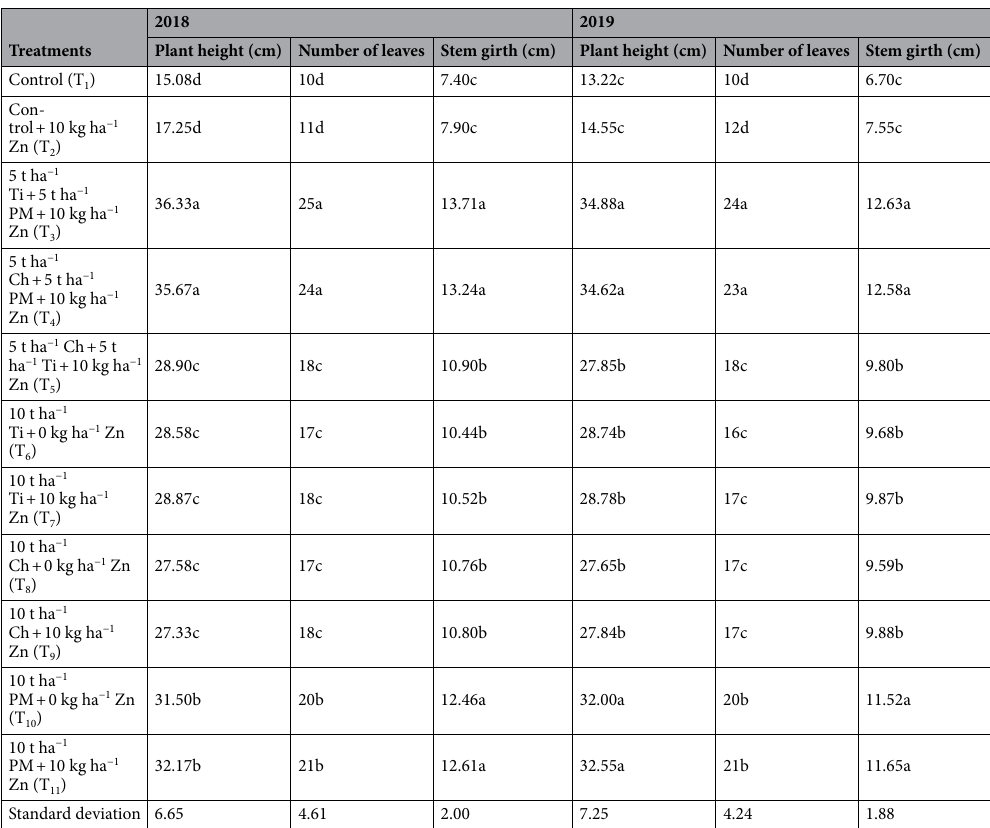
Table 3. Effects of soil applied Zn-fertilizer, green biomass and poultry manure on vegetative parameters of okra at 7 weeks after sowing (WAS) in 2018 and 2019 cropping seasons. Means in a column under any given treatment followed by the same letter do not differ significantly at p ≤ 0.05 by Duncan multiple range test. Ti tithonia, Ch chromolaena, PM poultry manure.